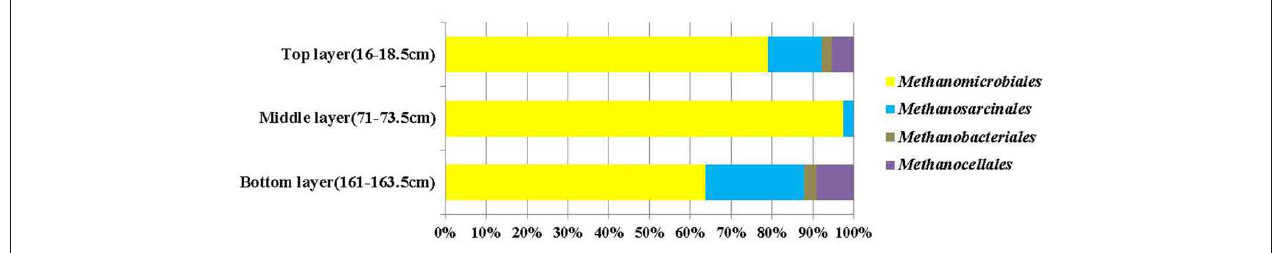
FIGURE 4 | Compositions of mcrA gene clone libraries from top, middle (SMTZ) and bottom layers. Groups shown include Methanomicrobiales , Methanosarcinales , Methanobacteriales, and Methanocellales